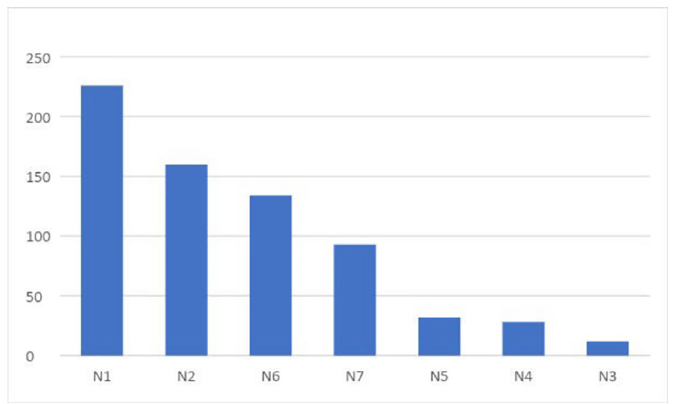
Fig 2. Number of patients included by each call-handler. N1-N7: Nurse 1 –Nurse 7. Theme 1 : Video triage improves patient assessment . According to the call-handlers, the